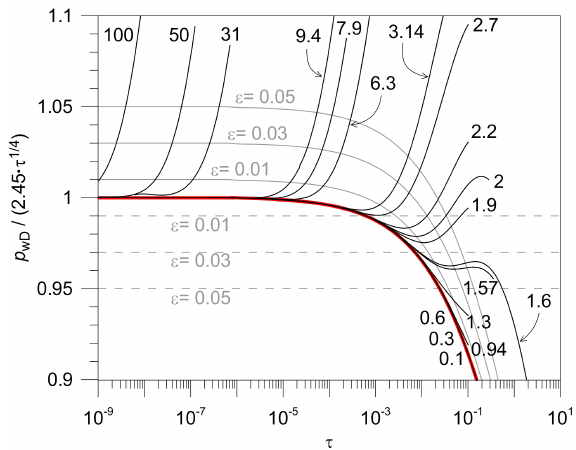
Fig. 7. Type curves of the normalized well pressure for indicated values of dimensionless fracture conductivity T D . The dashed grey lines are the deviation lines representing the end time using the tran- sition criterion (18); the solid grey lines are the deviation lines rep- resenting the reflection criterion